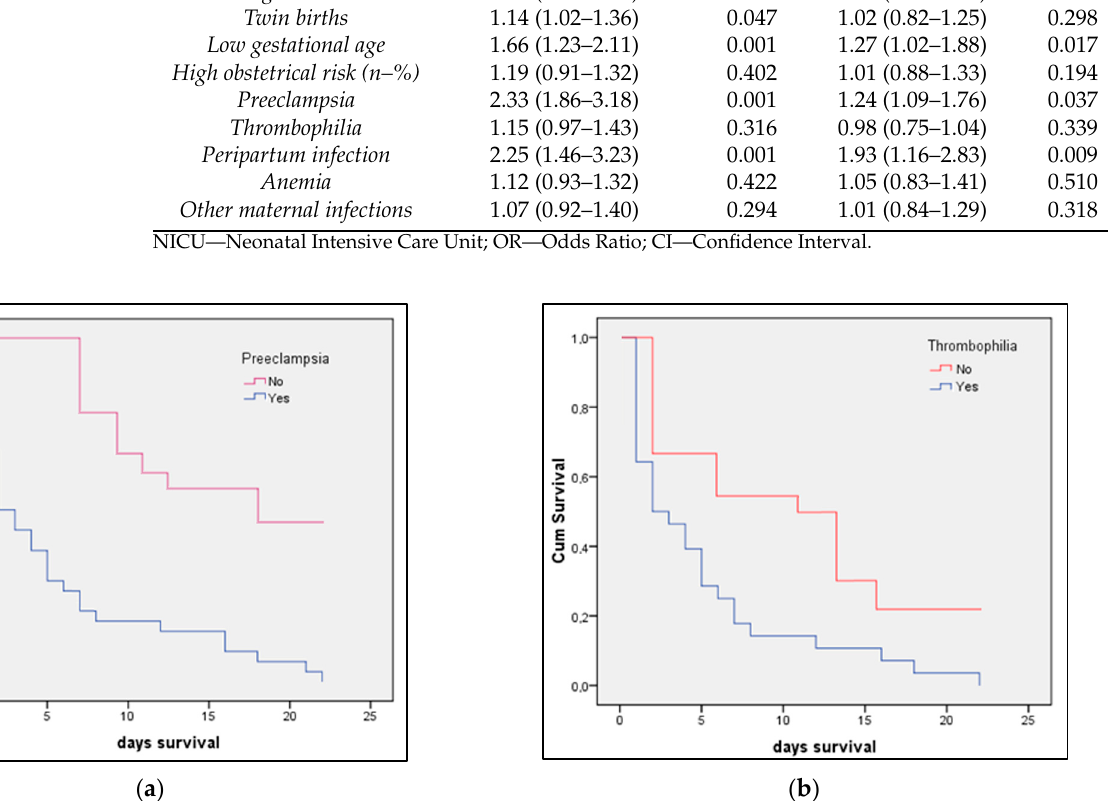
Figure 3. ( a , b ) Kaplan–Meier plots of preterm newborn survival (in days) from mothers with preeclampsia or thrombophilia compared with newborns from mothers without preeclampsia or thrombophilia.